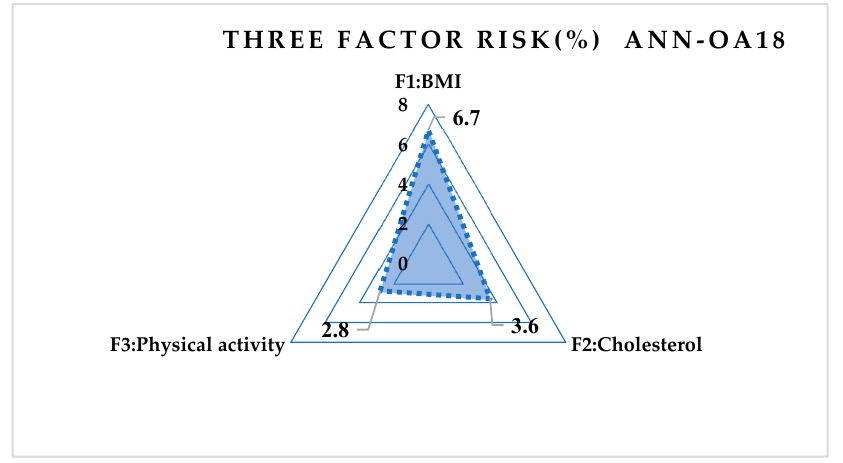
Figure 7. Influence of three risk factors on ANN-OA18.